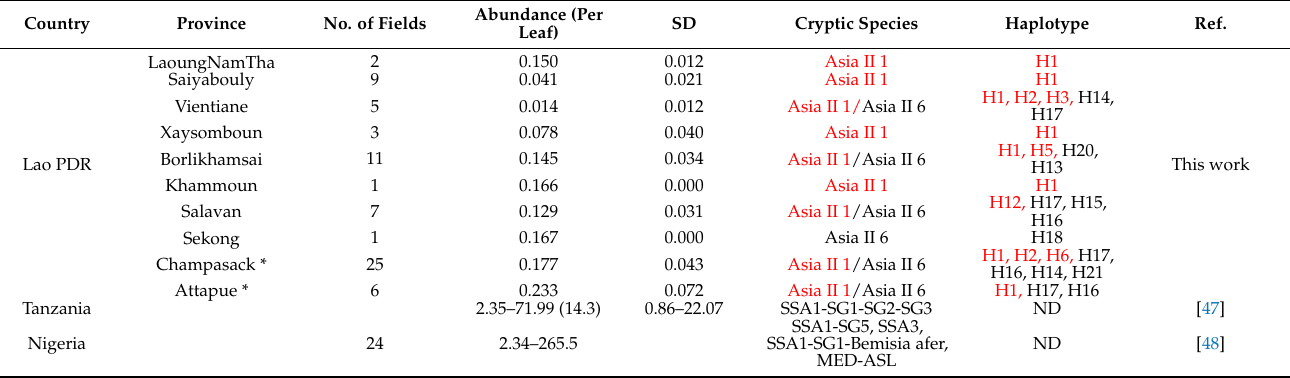
Table 1. List of surveyed provinces and abundance data for whiteflies associated to cassava in Lao PDR. Comparative whitefly abundance data from Tanzania and Nigeria is included. SD = standard deviation. The asterisks indicate provinces where CMD was observed. Asia II 1 and its haplotypes are indicated in red.